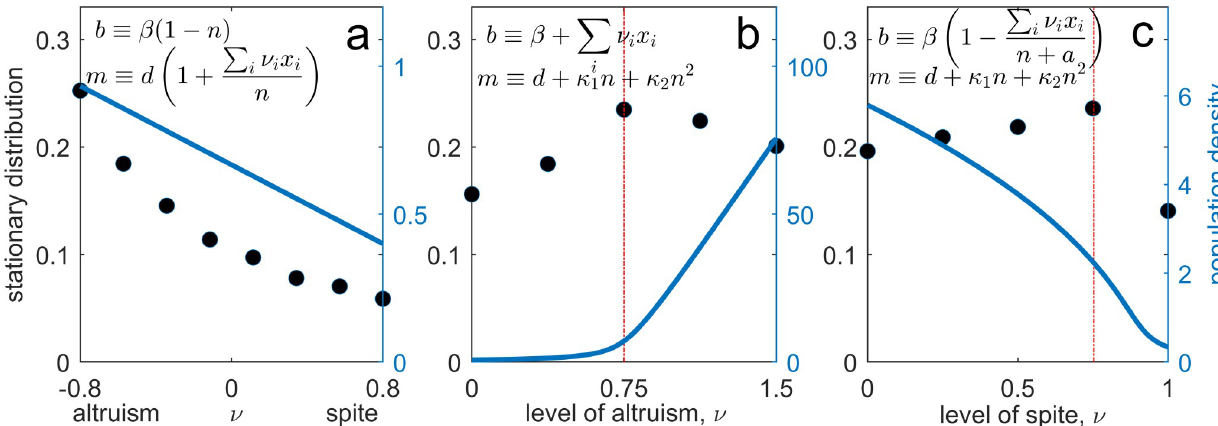
Fig 3. Role of demographic stochasticity in the evolution of cost-free social traits. Each subplot is the model indicated by the per-capita birth and death rates, b and m , with n = ∑ i x i . The black circles are the results of 10 4 simulations of the system of SDEs (S1 Appendix) and represent the probability of observing the simulation in a given state (left y -axis). The blue curve is the expected population density of a population monomorphic for the trait value (right y -axis). If population size alone was sufficient to predict which trait is favoured, we would expect a close match between the stationary distribution (black circles) and population size (blue curve)—this does not occur because what is important is the ratio T / n . Indeed, as predicted by consideration of (1), the stochastically favoured trait for subplot a is altruism, whereas for subplot b and c it is the trait value at the red dashed line. Parameter values used: subplot a , { β , d } = {3, 1}, subplot b , { β , d , κ 1 , κ 2 } = {1, 0.5, 0.75, 0.01}, and subplot c , { β , d , κ 1 , κ 2 , a } = {8, 1, 0.05, 0.2, 0.05}. All simulations used O = 10 4 and assumed type i mutates to type j at a per-capita rate μ = 10 − 6 .